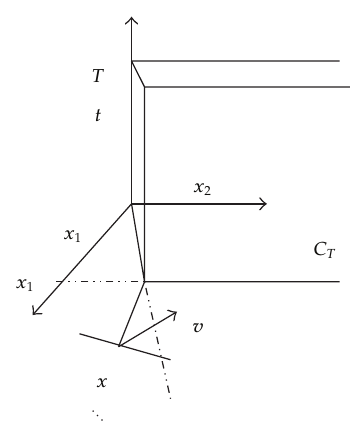
Figure 1: Exterior contingent